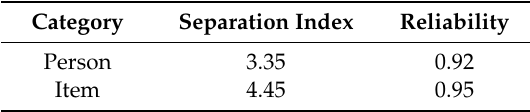
Table 4. Person and item separation index of the K-PSI-SF.